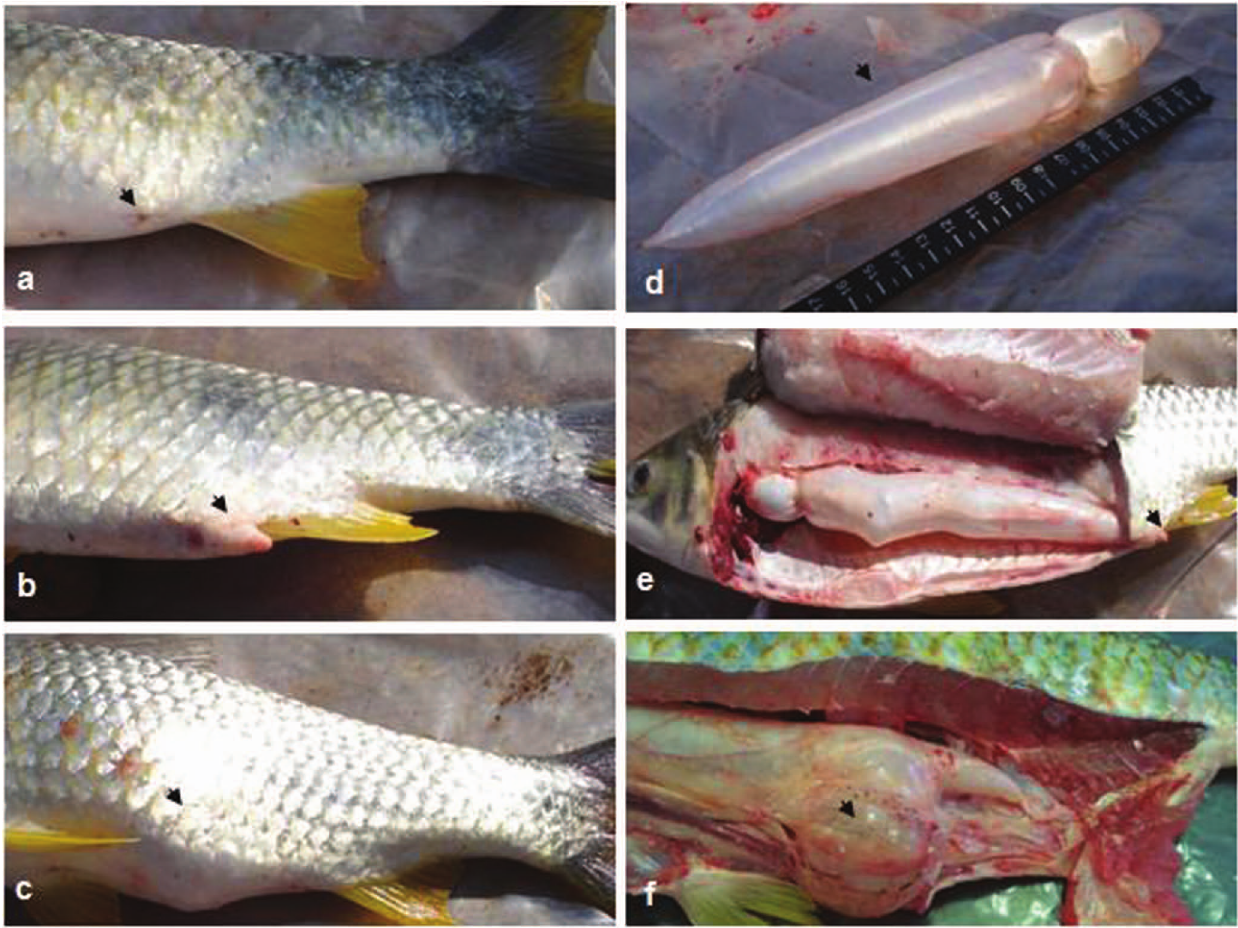
Fig. 1. Urogenital opening of piapara Leporinus obtusidens . a ) normal; b ) the arrow indicates exposure of the posterior portion of the swimbladder; c ) irregular coelomic cavity caused by swimbladder deformity without exteriorization. Swimbladder of piapara Leporinus obtusidens ; d ) normal; e ) exposure of the posterior portion at the base of the anal fin opening; f ) sac- like projection without